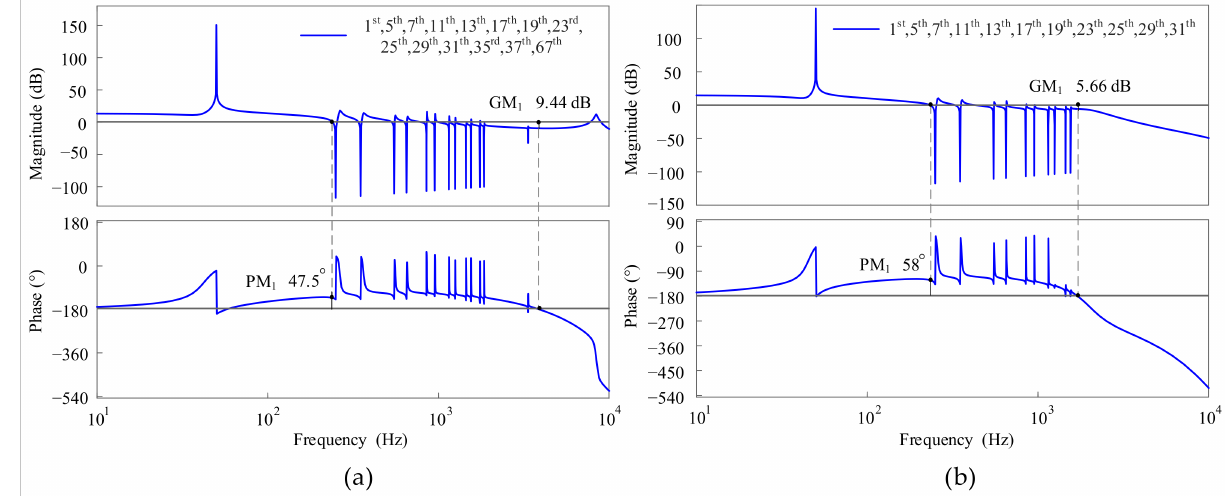
Figure 24. Bode plots of the open-loop transfer function G ol_pro ( s ): ( a ) L g = 0; ( b ) L g = 2.6 mH. The Bode plot of G ol_pro ( s ) is shown in Figure 24b when L g = 2.6 mH. For ease of observation, the highest order of the harmonic resonance controller applied is the 31st order. The phase margin PM 1 and the gain margin GM 1 of G ol_pro ( s ) are 58 ◦ and 5.66 dB, respectively. They both satisfy the stability margin requirements of the classical control